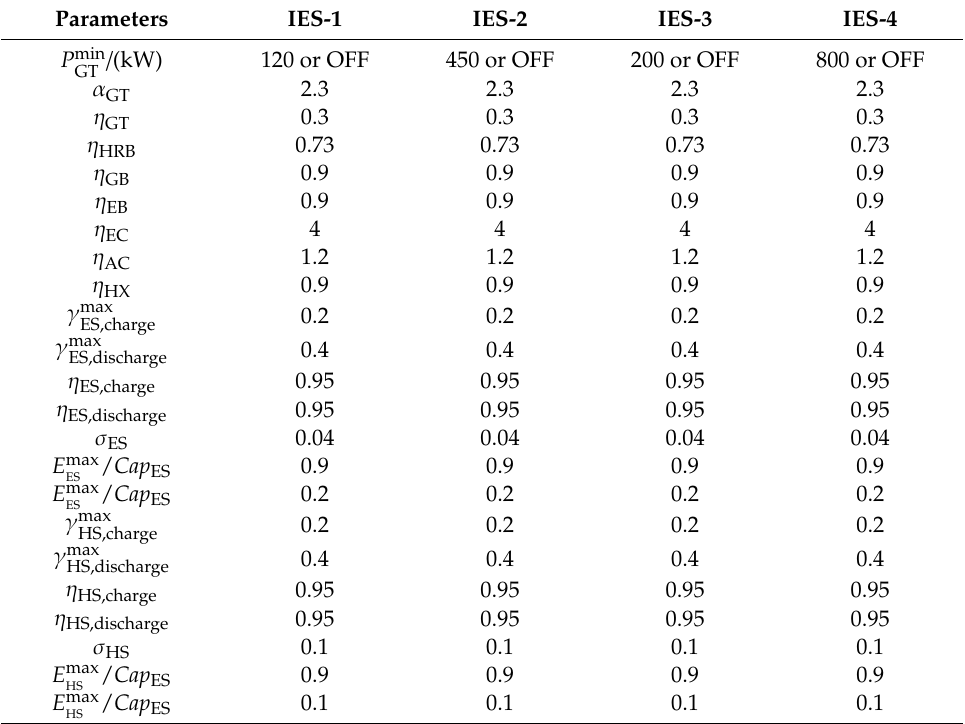
Table 4. Equipment parameters of IES in each